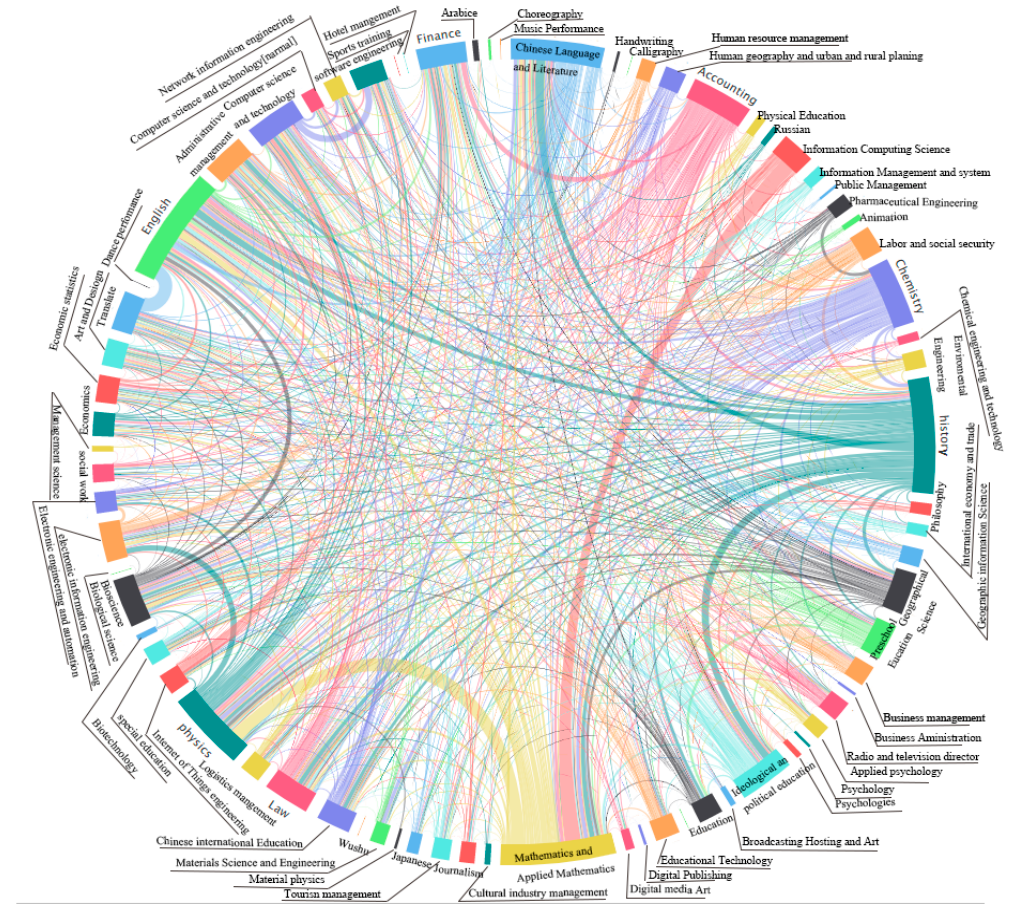
Figure 2. Similar group learning interest networks among majors.